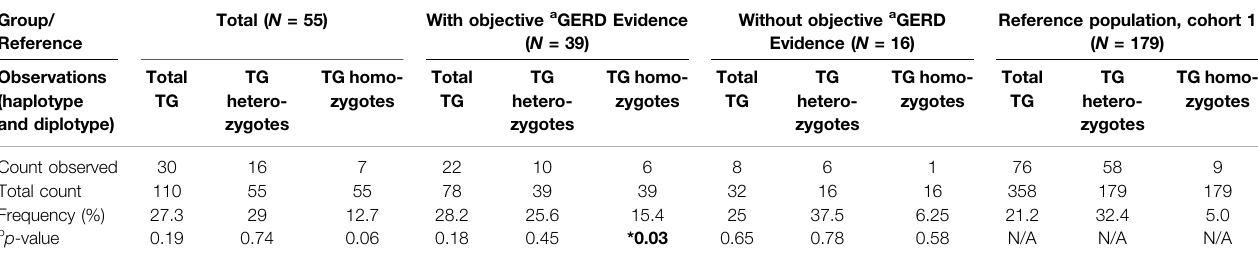
TABLE 3 | Group comparison of haplotype and diplotype for CYP2C:TG between reference population and cases (overall and within subgroups). Group/ Total ( N = 55) With objective a GERD Evidence ( N = Reference